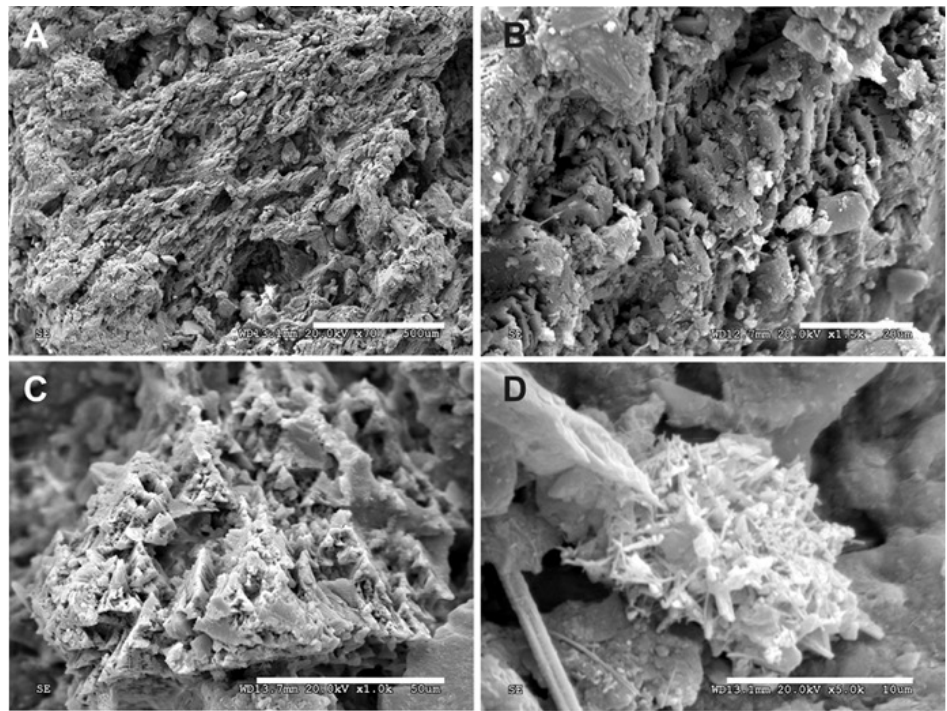
Figure 9. SEM micrographs of sparitic calcite crust: ( A , B ) partially dissolved scalenohedral calcite crystals (Sample 304); ( C ) detail of calcite scalenohedral terminations (Sample 696); ( D ) microcrystalline aggregate with needle-fibre calcite (NFC) crystals (Sample 696).